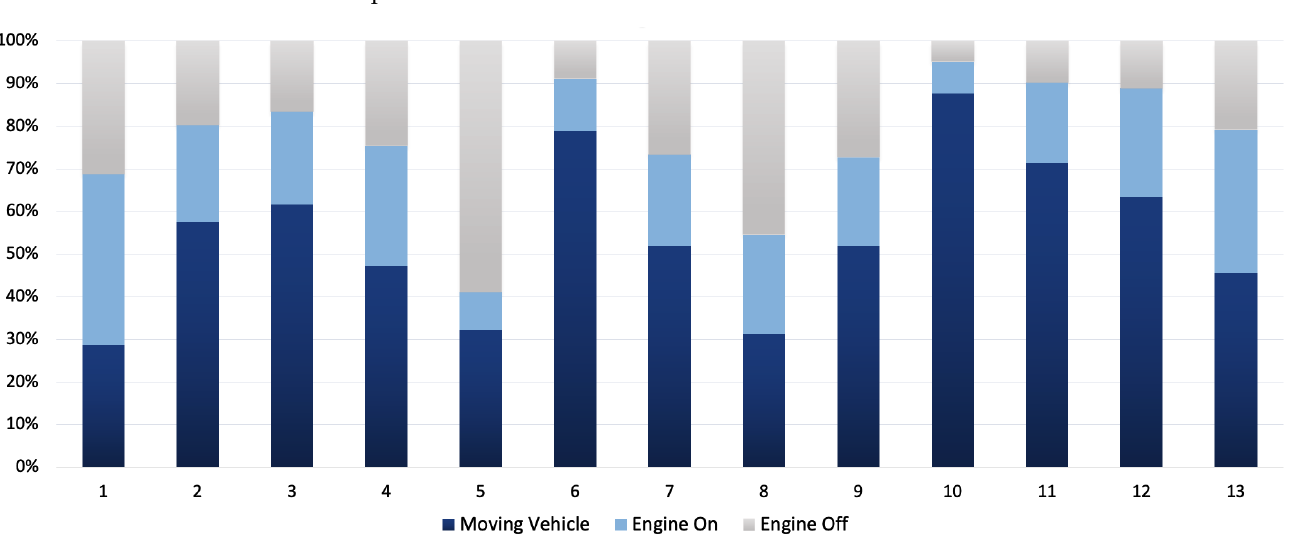
Figure 12. Engine status and vehicle movement (i.e., speed greater than zero) during each delivery in the field-trial. Table 4. Delivery segments during the